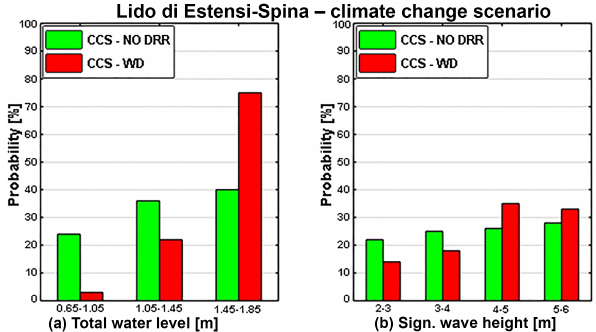
Figure 17. Distribution of boundary conditions ( a TWL and b Hs) for constrained uniform flood damages in the climate change sce- nario for Lido degli Estensi–Spina. The configuration without mea- sures (green bars) and under the implementation of the winter dune (red bars) were